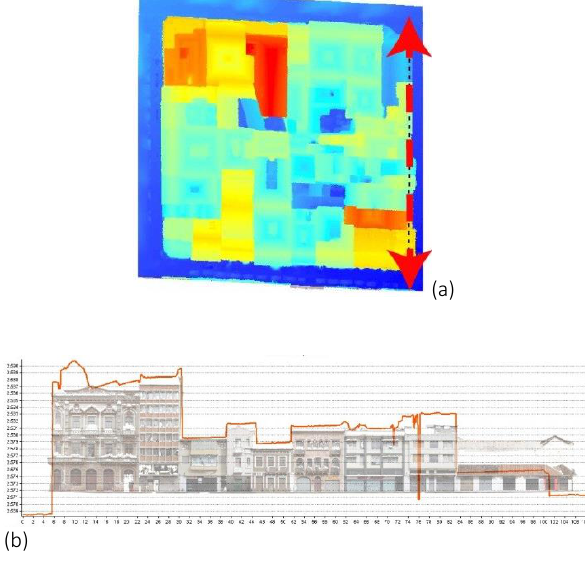
Figure 4. City building block skyline defined by terrestrial photogrammetry (a) and confirmed by the MDS (b). As a complimented, the Terrestrial Laser Scan (TLS) was used for the identification of detailed elements at the facades and interior spaces. For some facades, the